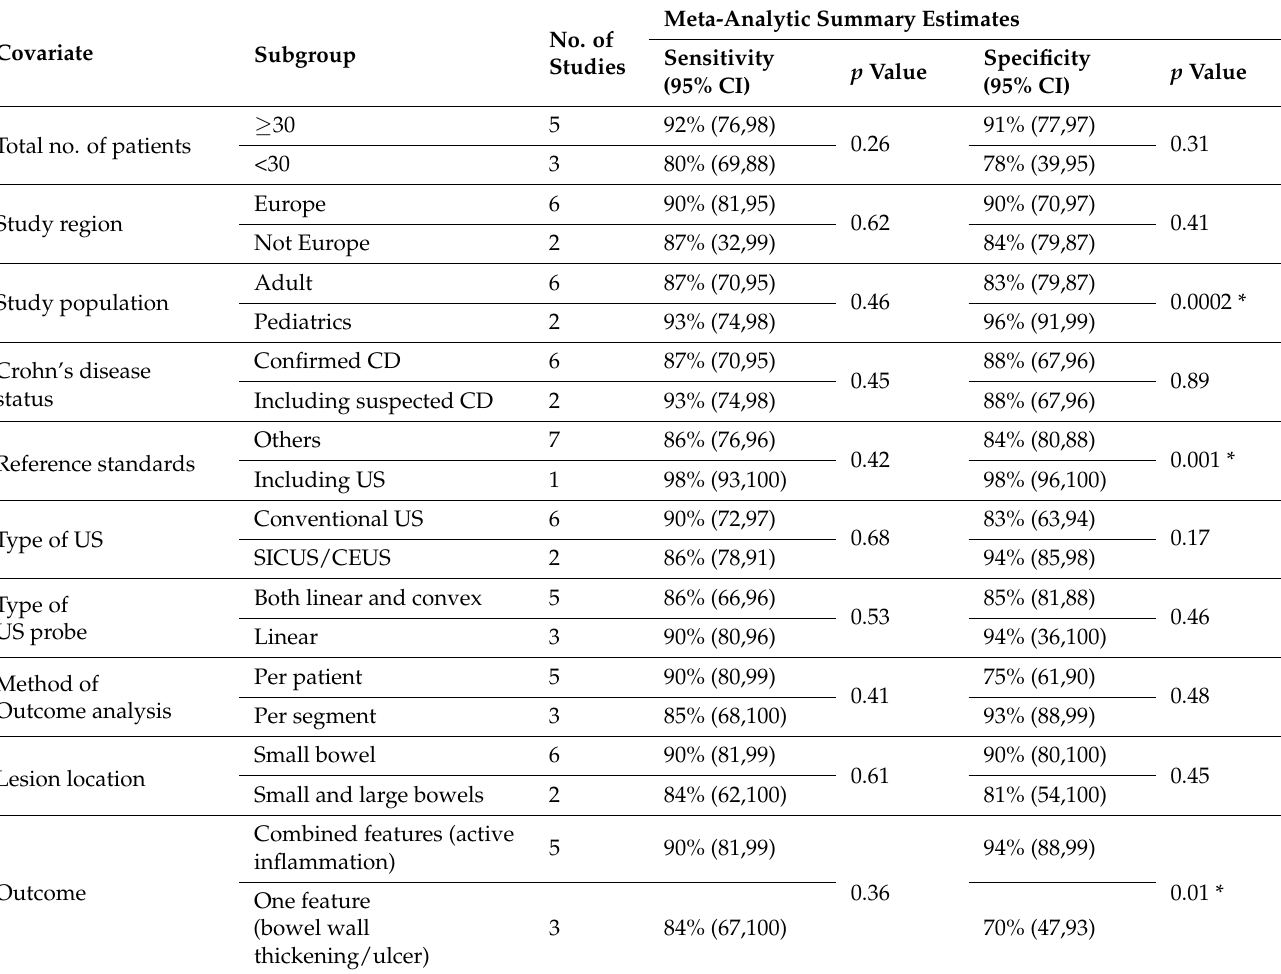
Table 4. Meta-regression analysis of the diagnostic performance of MRE in diagnosing active bowel lesions in patients with Crohn’s